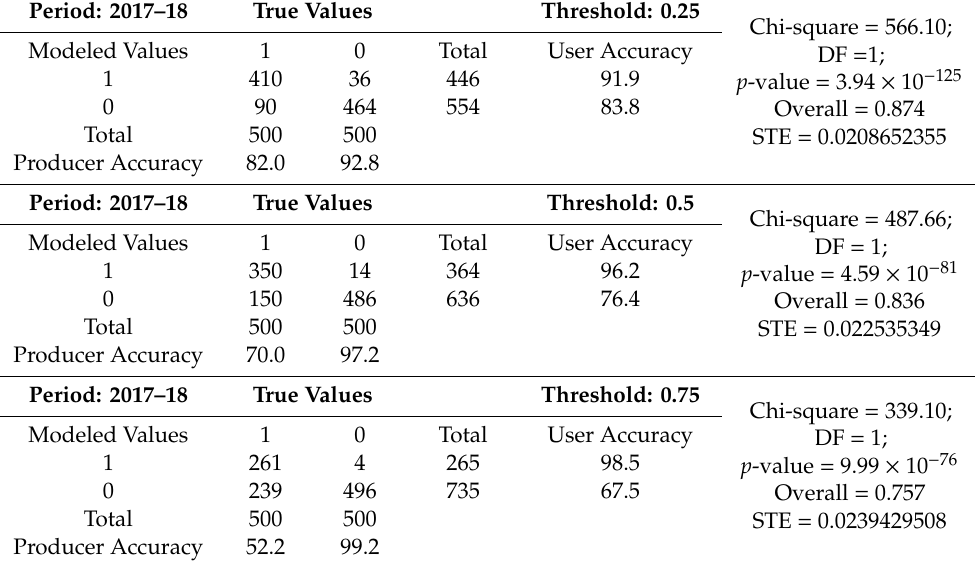
Table 5. Accuracy Assessment report for the period 2017–18, as estimated with the Raster Utility tools based on a validation dataset of 1000 random samples (50% in each class). Random Forests results were split into treatment and no treatment pixels based on three thresholds (0.25, 0.5 and 0.75).